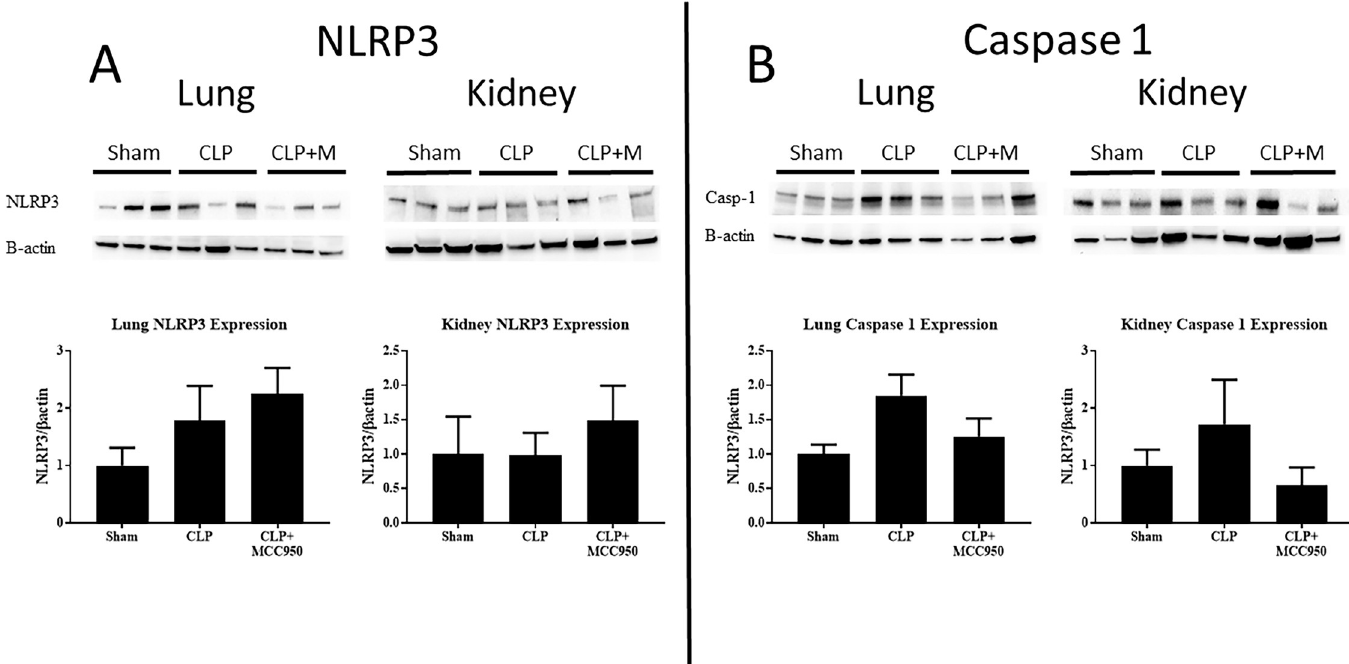
Fig 1. NLRP3 and Caspase 1 protein. NLRP3 (A) and Caspase 1 (B) protein levels were quantified in kidney and lung via western blot and normalized to β -actin. NLRP3 (A) and Caspase 1 (B) expression in lungs and kidneys in response to sepsis and after treatment with the NLRP3 specific inhibitor, MCC950 (n = 5-6/group). � p < 0.05 vs Sham, #p < 0.05 vs